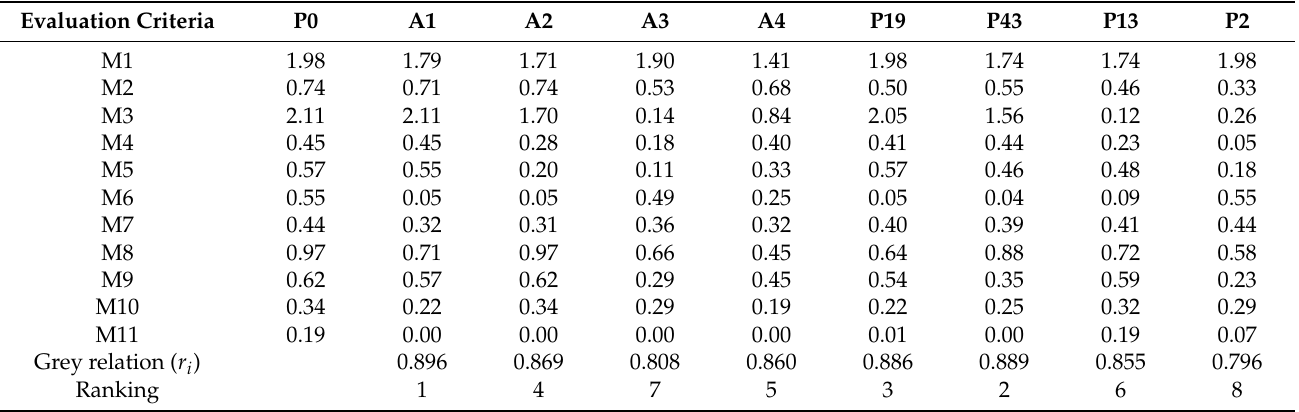
Table 11. Information table about the eight comparative sequences and the reference sequence after